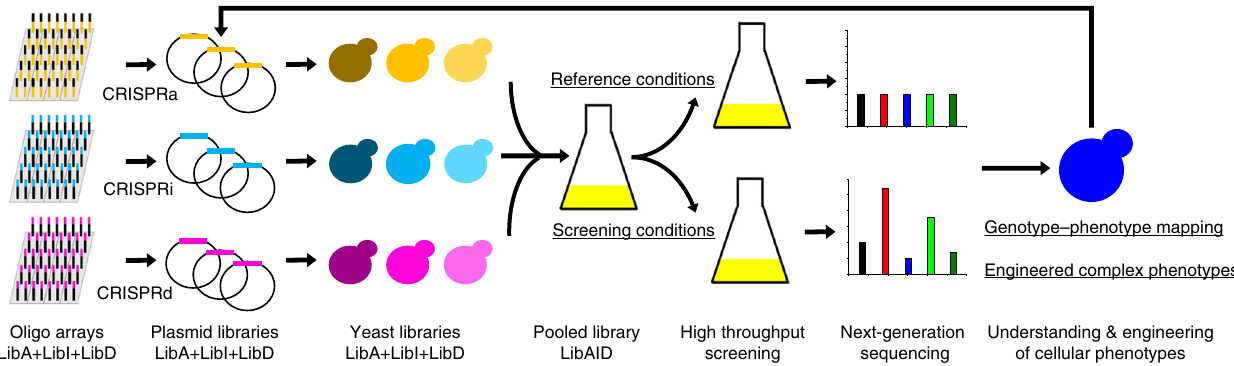
Table 1 Construction and characterization of the iMAGIC plasmid library.